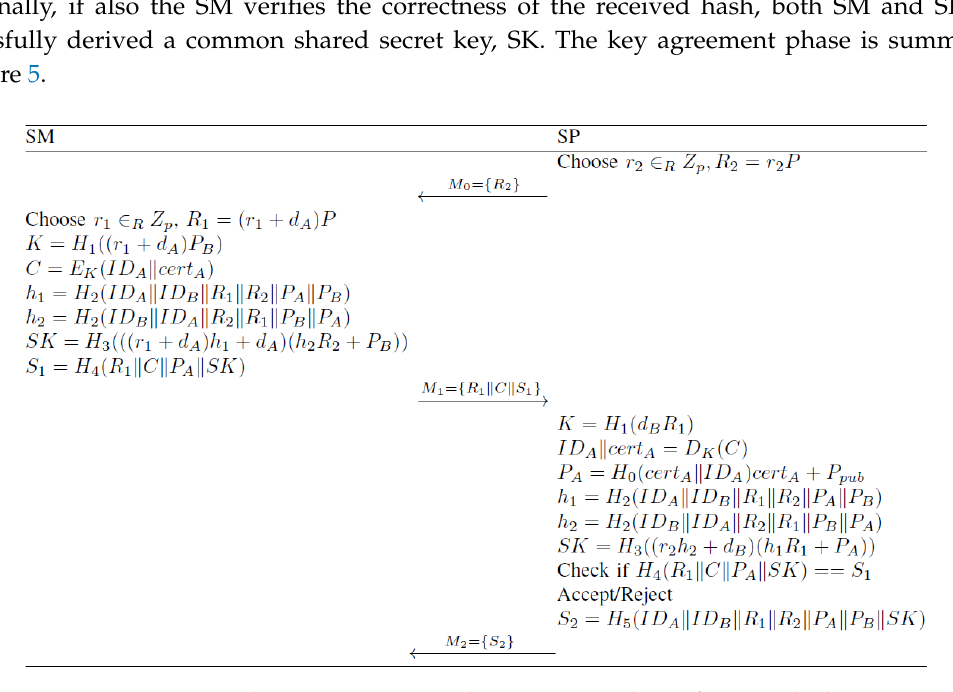
Figure 5. Steps and computations in the key agreement phase of proposed